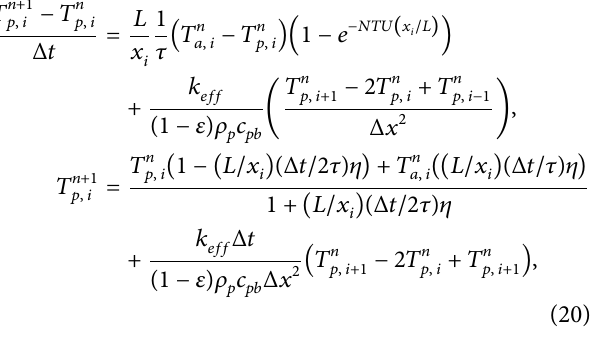
While and designates the current and front spatial nodes 𝑖 𝑖 + 1 in the longitudinal directions, and next time step.